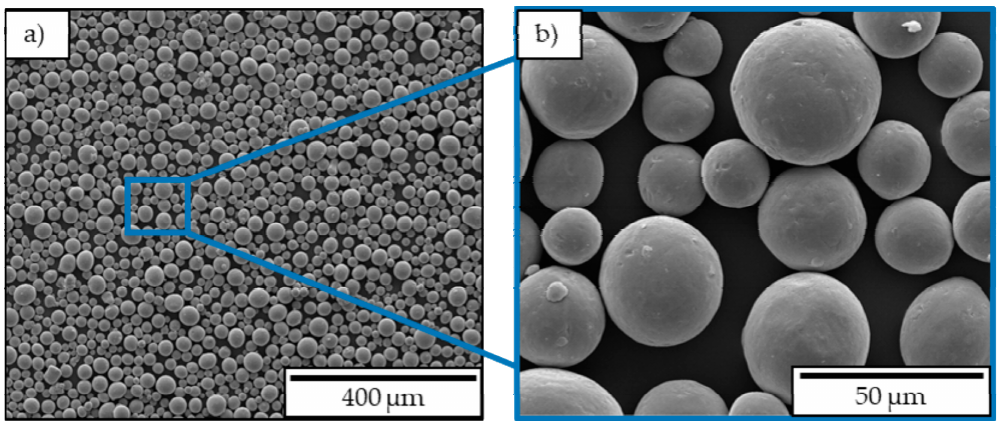
Figure 3. SEM images of Ti-6Al-4V powder: ( a ) × 250; ( b ) × 2000 magnification.